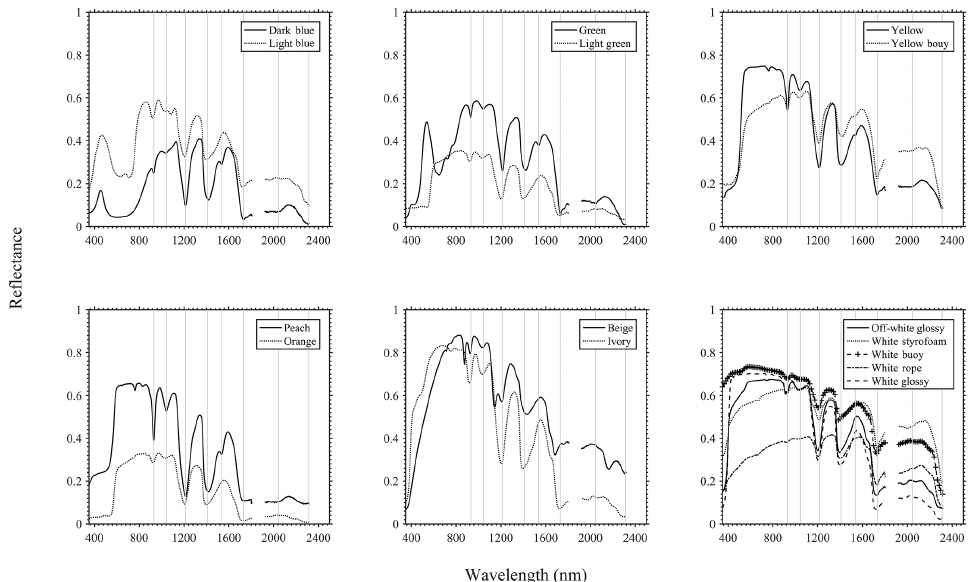
Figure 3. Spectral reflectance of dry washed-ashore macroplastics harvested along the western coast of the USA. Absorption features noted in marine-harvested microplastics are highlighted by the vertical lines (centred around ∼ 931, 1045, 1215, 1417, 1537, 1732, 2046 and 2313nm).